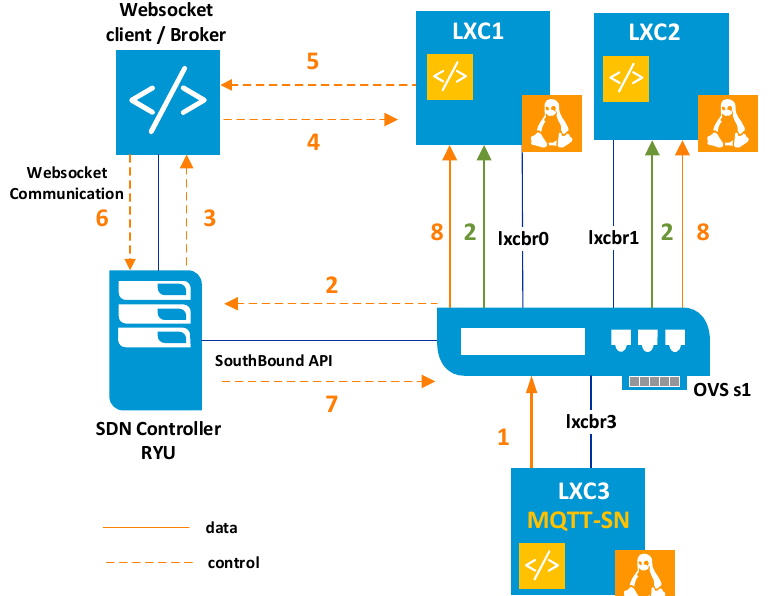
Figure 3. Deployed architecture (Cluster Manager is omitted). The visualized messages are numbered according to their relative order of occurrence in the system after a new data flow is admitted to the system, i.e., starting from the data message number 1.